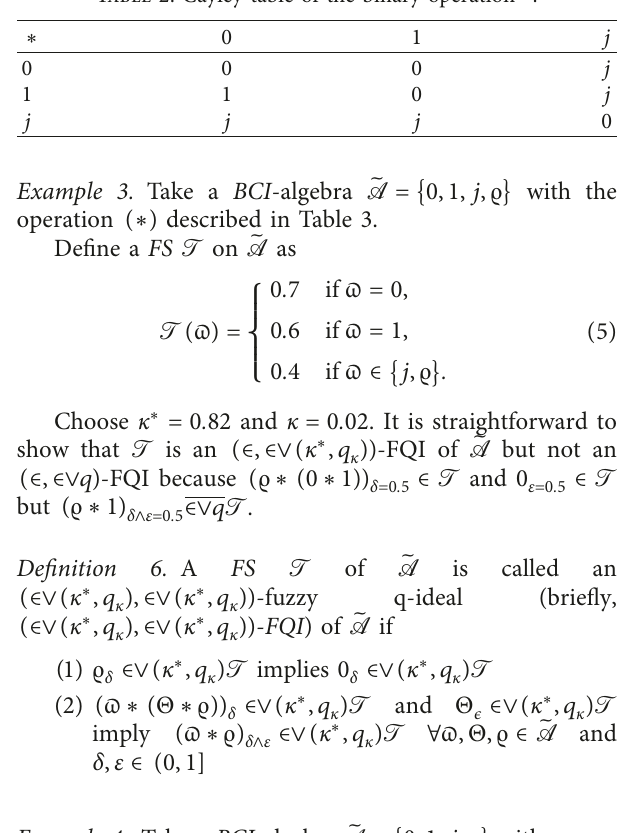
Table 2: Cayley table of the binary operation ∗ .